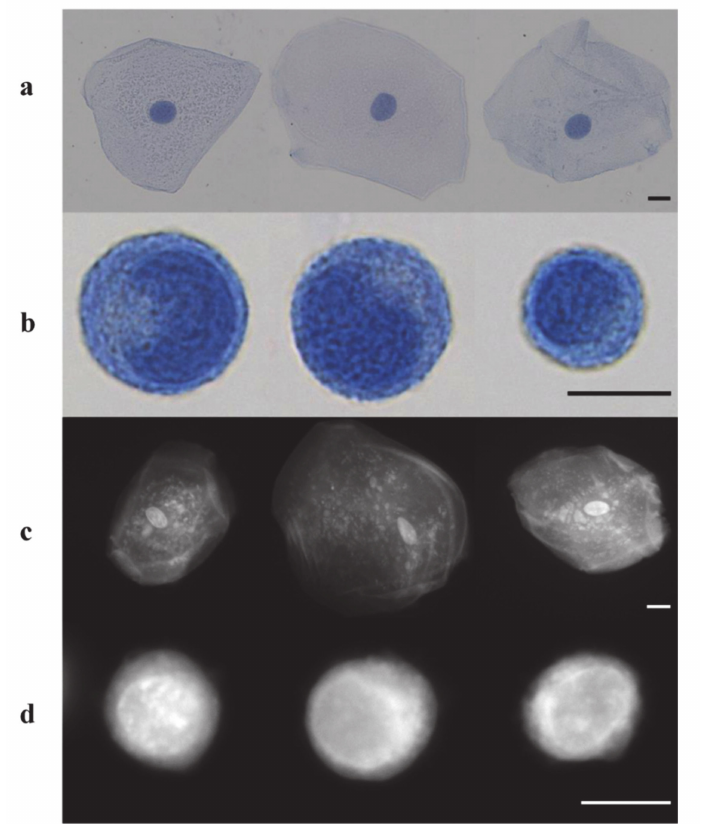
Figure 4. Visual diagnosis comparison of Papanicolaou and proflavine-stained normal oral cells and CAL 27 cell line. ( a ) Papanicolaou-stained normal oral cells. ( b ) Papanicolaou-stained CAL 27 cells. ( c ) Fluorescent images of proflavine-stained normal oral cells. ( d ) Fluorescent images of proflavine-stained CAL 27 cells. Scale bars = 10 µ m. Reproduced from [73] (open access